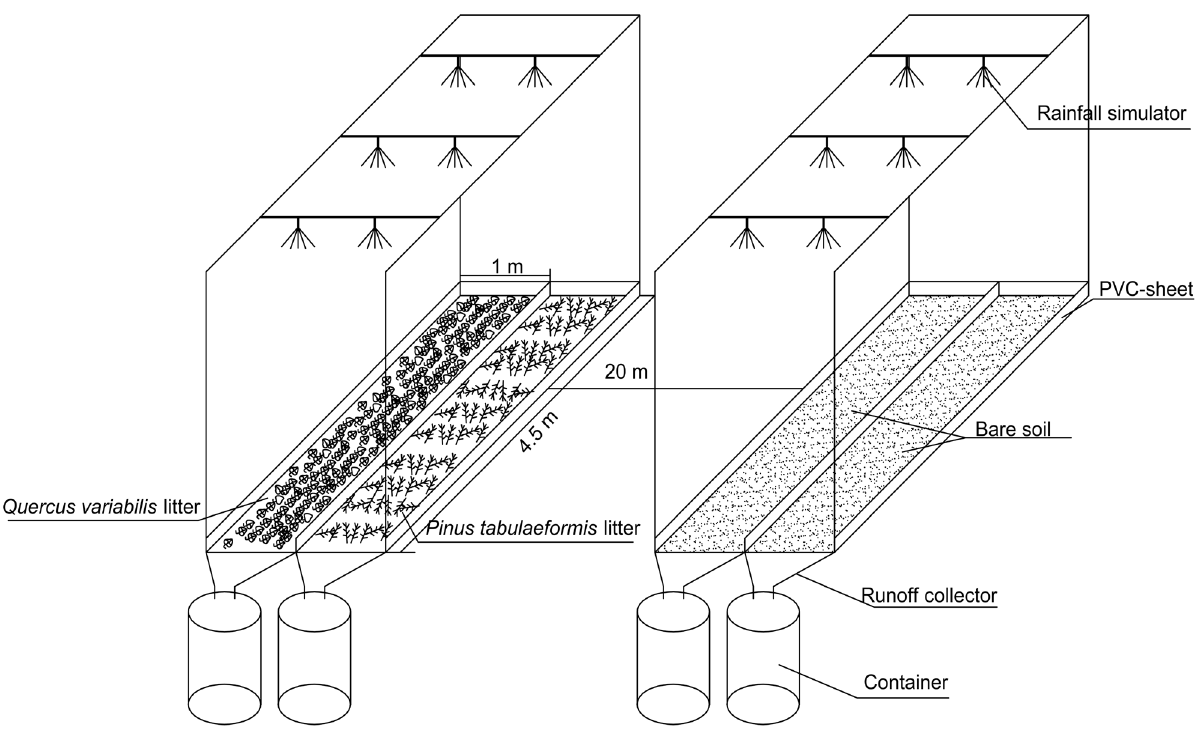
Figure 2. A single set of schematic diagram of experimental runoff plots.